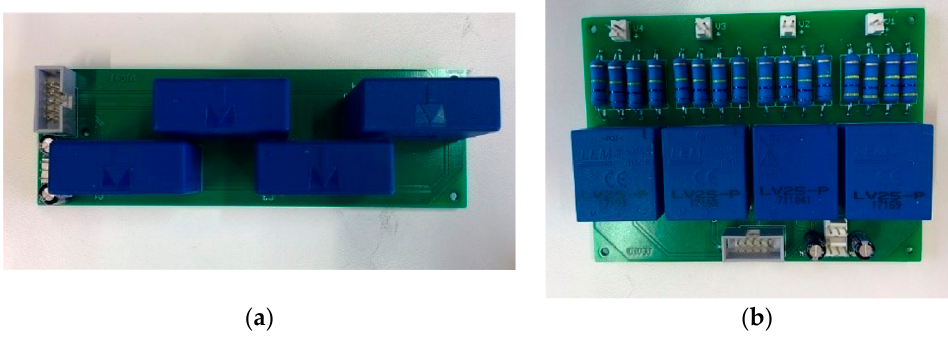
Figure 5. Sensors printed circuit boards for the experimental setup for measuring current and voltage magnitudes: ( a ) current sensors board and ( b ) voltage sensor board.